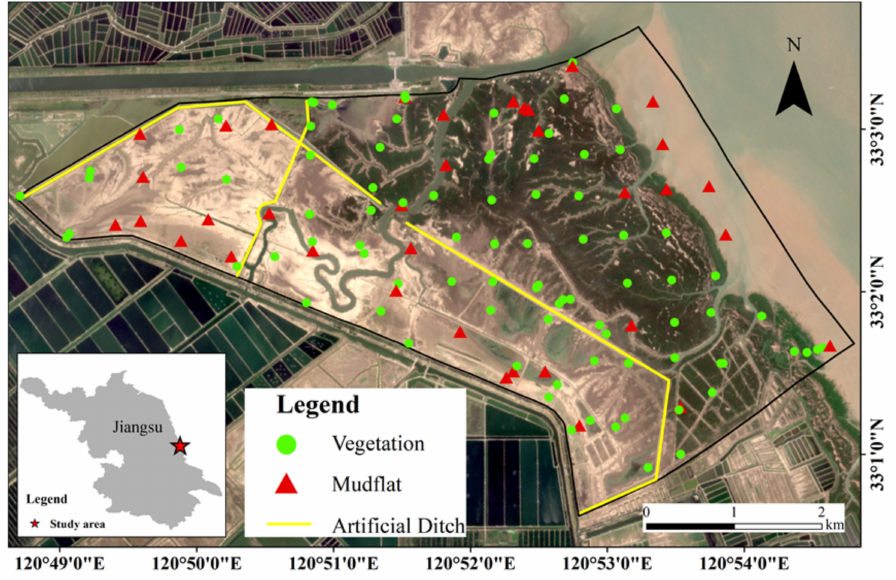
Figure 1. Locations of the study area and the sampling points of vegetation ( n = 88) and mudflat ( n = 36) in